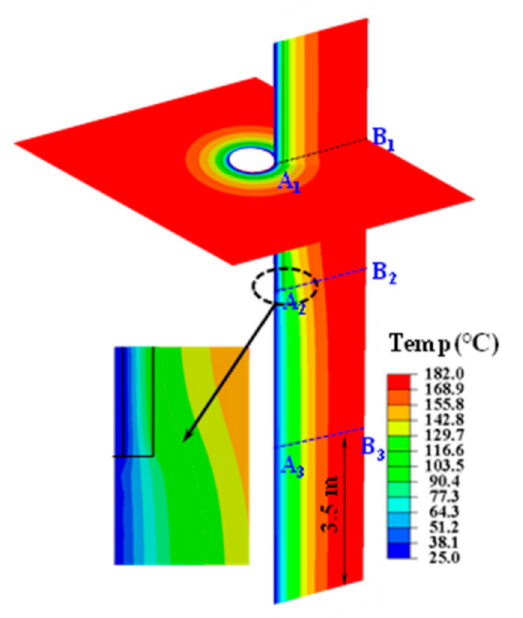
Figure 4. Temperature distribution near the wellbore after 3.0 days of water